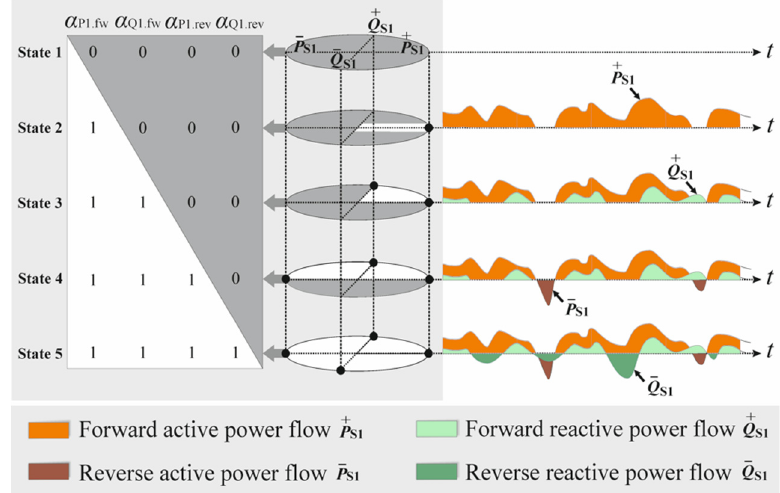
Figure 4. Conceptual illustration of the main five operating states. Here, the signs “+”/“–” mean import/export active/reactive power at a slack bus S 1 , respectively, as defined in [2].